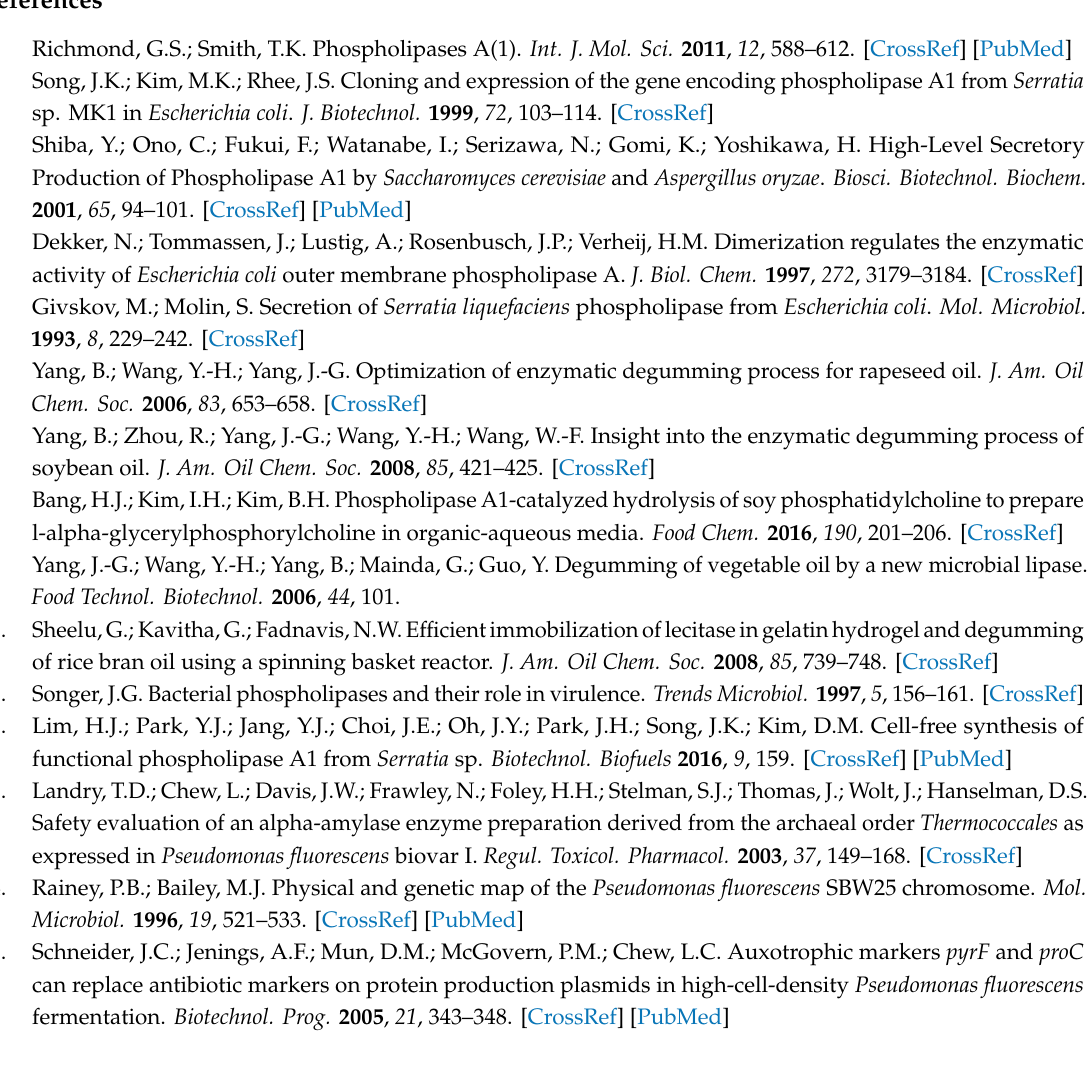
Figure S1: Construction of P. fluorescens ZYAI, Figure S2: Secretion of PlaA by the ABC transporter